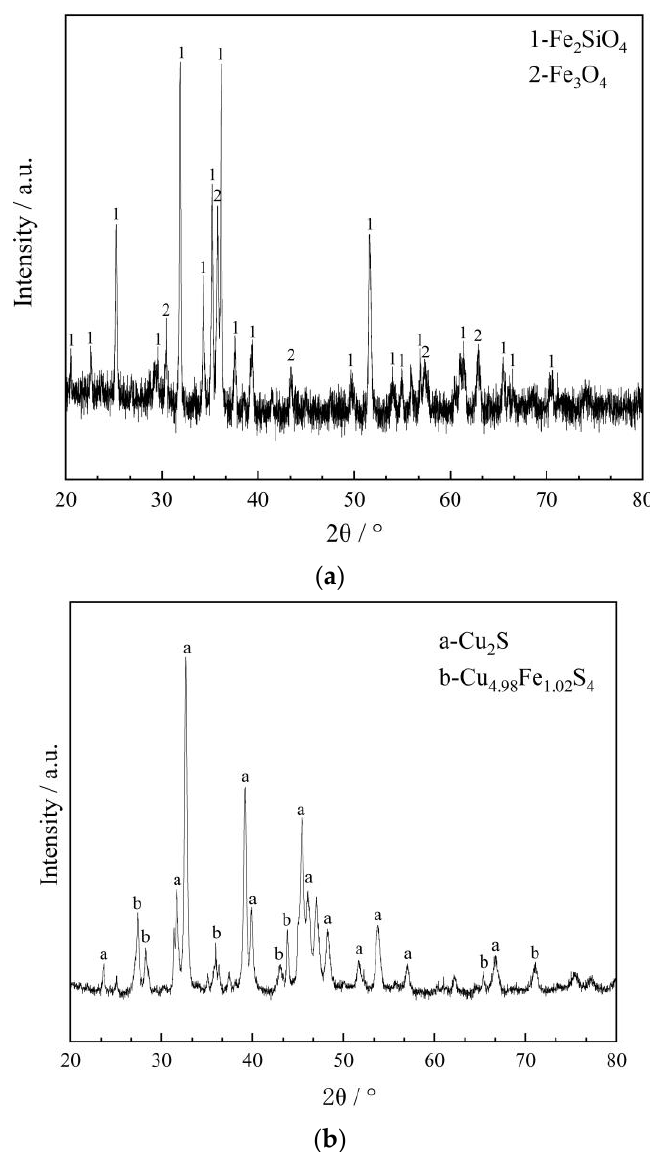
Figure 2. The phase analysis results for copper slag and copper matte. ( a ) copper slag ( b ) copper matte